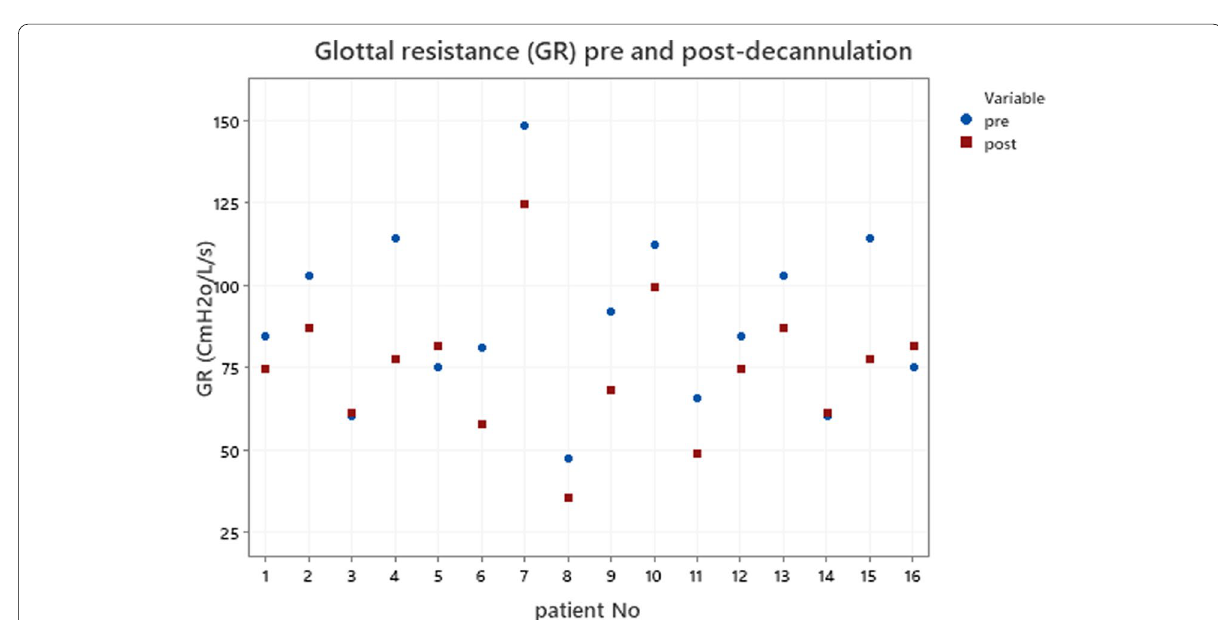
Fig. 6 Plot distribution of glottal resistance in all studied subjects before and after